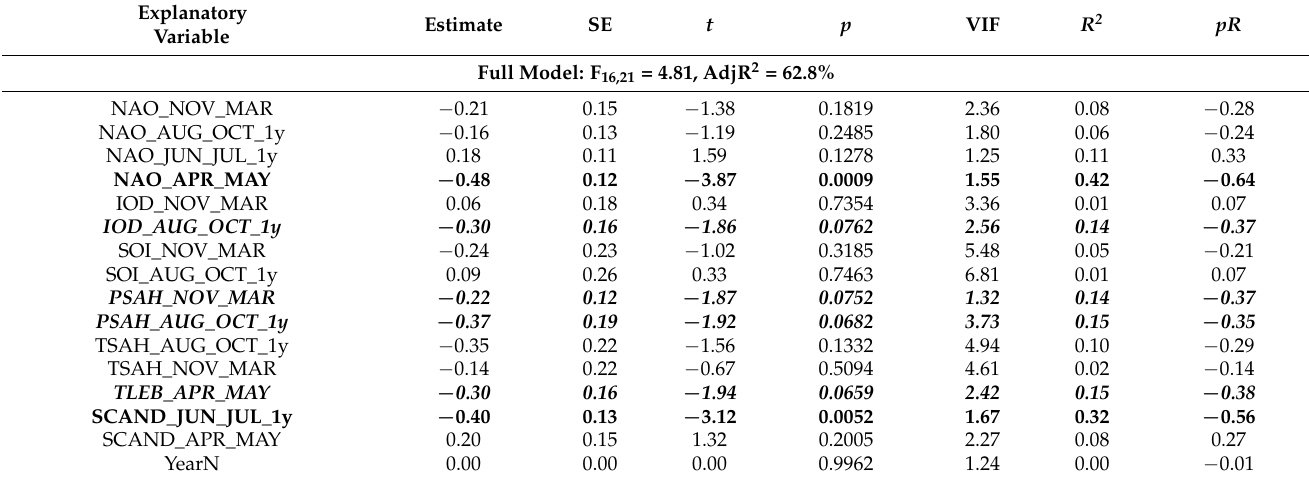
Table A10. Relationships between 15 climate variables and year in full models and Annual Anomaly of the timing of spring migration for the Willow Warbler Phylloscopus trochilus caught at Bukowo, Poland, in 1982–2021 Symbols as in Tables 1 and A5. p < 0.05 marked in bold face, 0.05 < p < 0.1 in bold italics .